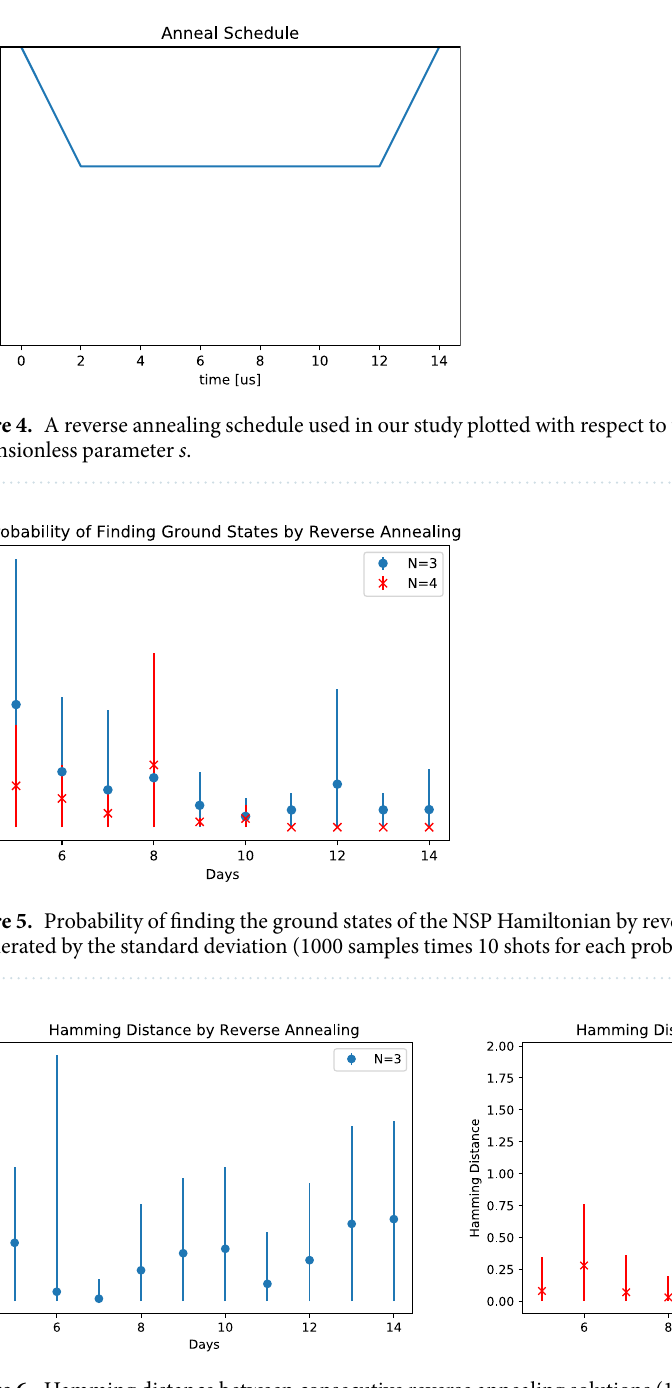
Figure 6. Hamming distance between consecutive reverse annealing solutions (1000 samples for each problem). Error bars are based on the standard